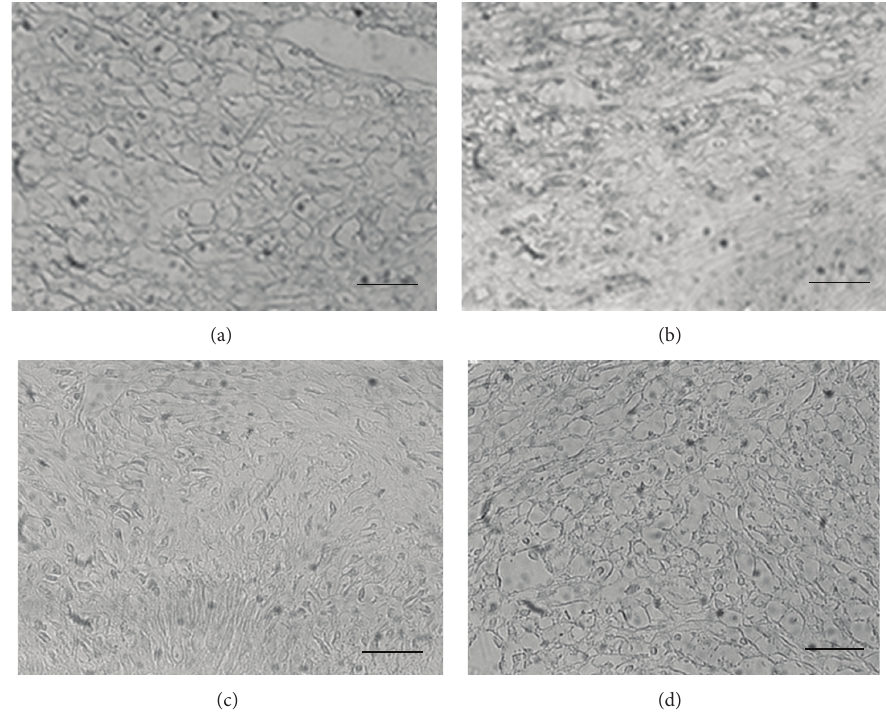
Figure 4: Effect of bFGF on apoptosis in rat palate. At 10 days after the excision, the head was resected under deep anesthesia with diethyl ether and fixed by immersion. Paraffin sections of the rat palate 6 ((a), (b)) and 12 weeks ((c), (d)) were stained with ApopTag Plus Peroxidase In Situ Apoptosis Detection Kit and observed by light microscopy. (a), (c): control group; (b), (d): bFGF injection group. The scale bars represent 25 𝜇